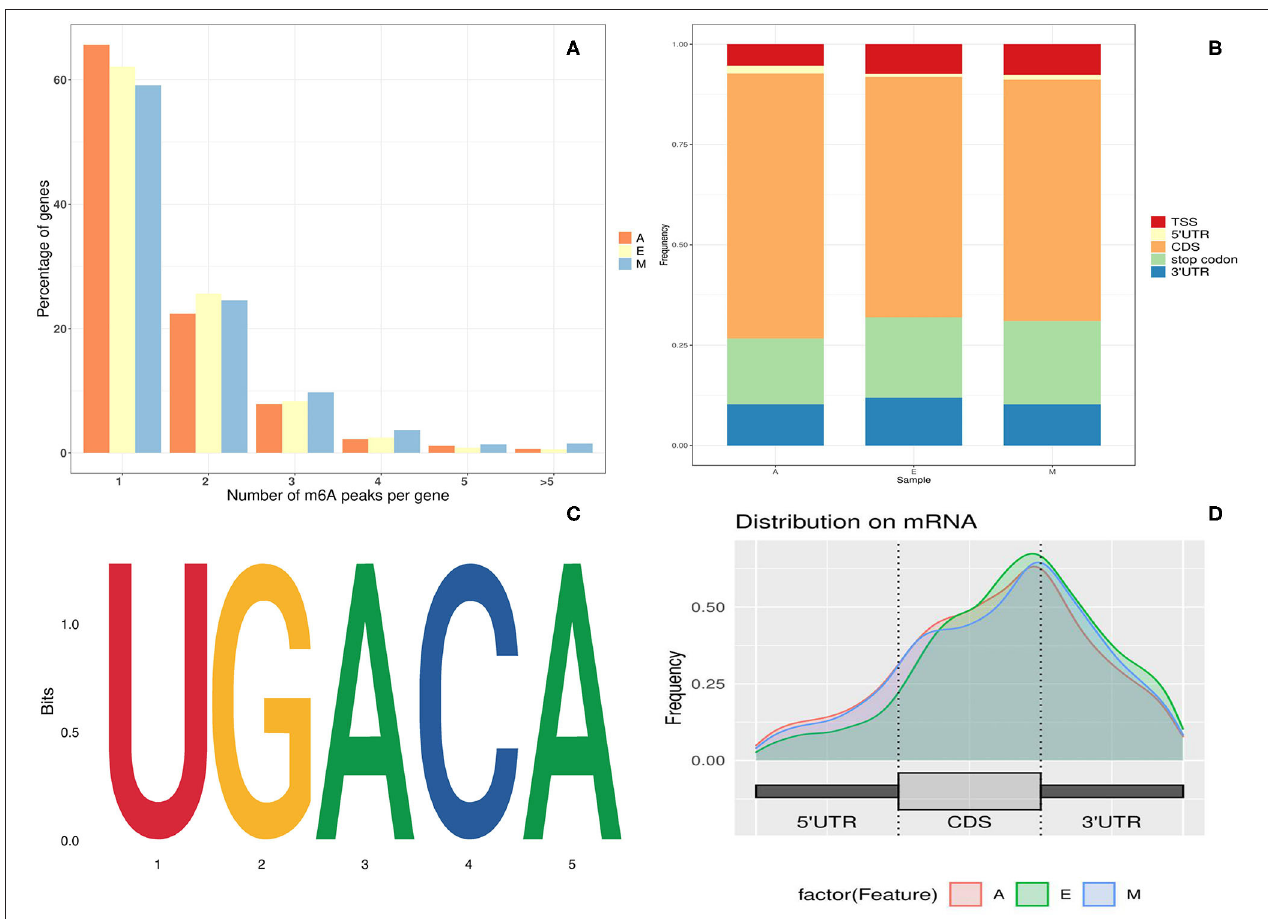
FIGURE 1 | Overview of N6-methyladenine (m6A) methylation in yak longissimus dorsi (LD). (A) Proportion of genes containing variant numbers of m6A peaks. (B) A graphical representation of the frequency of m6A peaks in five non-overlapping segments in the three developmental stages. (C) Motif sequence containing m6A. (D) Distribution of summits of m6A peaks along with